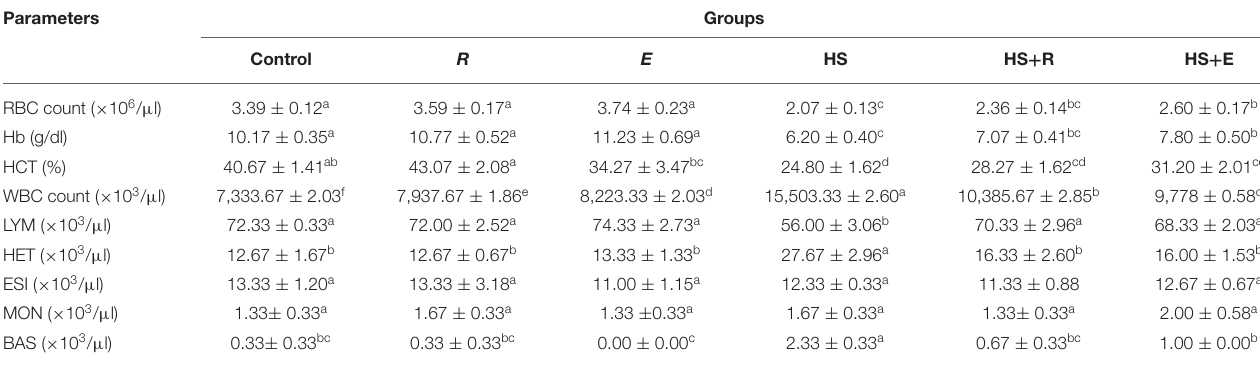
TABLE 5 | Effects of supplementation with digestive enzymes and/or Ruminococcus sp. on the hematological parameters of broiler chicken under heat stress (at day 42). Parameters Groups